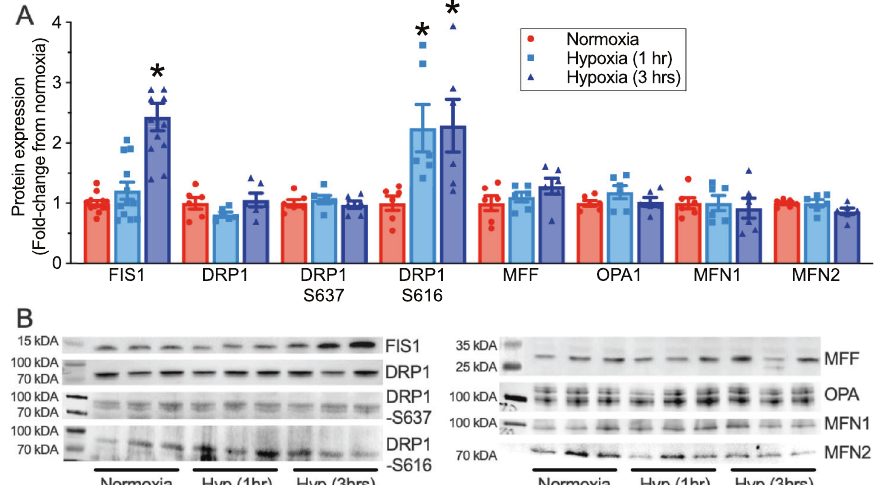
Fig. 7 Hypoxia activates mitochondrial fi ssion, but not mitochondrial fusion. A Summary of the expression of mitochondrial fi ssion proteins in interscapular brown adipose tissue (iBAT) homogenates from naked mole-rats held at 30 °C in normoxia (21% O 2 , red bars) or after 1 or 3 h of hypoxia (7% O 2 , light and dark blue bars, respectively; n = 12 biologically independent samples for FIS1 and 6 biologically independent samples for all other proteins). B Western blot images of protein bands from ( A ). Data are mean ± SEM. Asterisks indicate signi fi cant difference from normoxic controls (one- way ANOVA with Tukey multiple comparisons test; F 2,33 = 23.83, p < 0.0001 for fi ssion protein 1 (FIS1); F 2,15 = 4.49 2, p = 0.0296 for dynamin-related protein 1-S616 (DRP1-S616); p > 0.05 for mitochondrial fi ssion factor (MFF), mitofusin 1 and 2 (MFN1 or 2), and optic atrophy 1 (OPA1)). Source data are provided as a Source Data fi